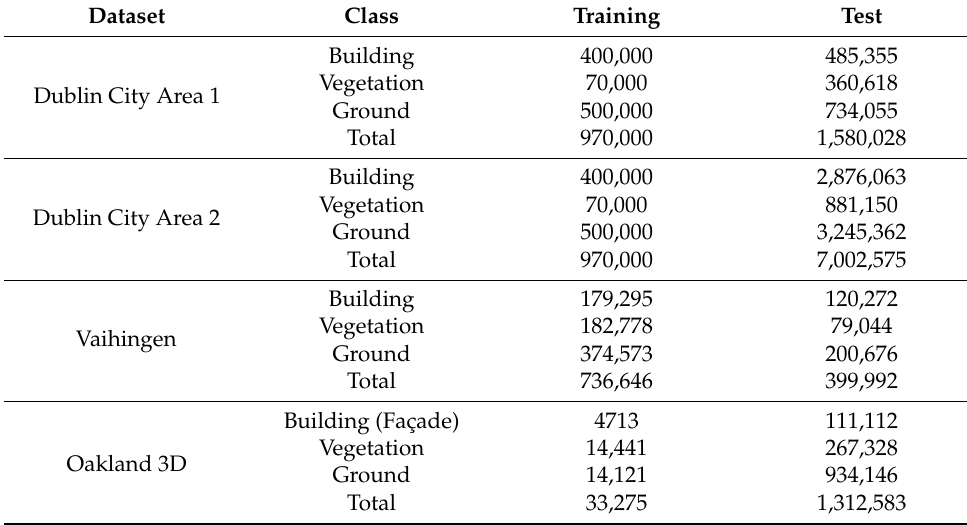
Table 1. Class distribution of the used